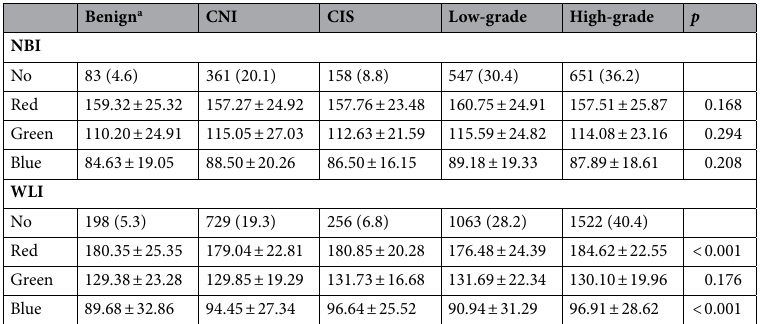
Table 1. Baseline RGB characteristics according to tumor grade. Data are expressed as number (%), mean ± standard deviation. CIS carcinoma in situ, CNI chronic non-specific inflammation, NBI narrow-band image, RGB red/green/blue, WLI white-light image. a Benign defined cystitis cystica or cystitis grandularis except CNI.